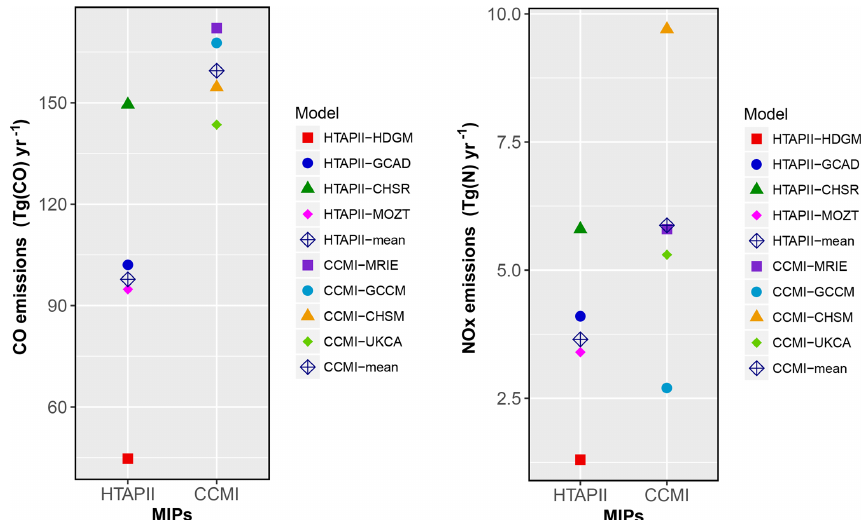
Figure 1. Shows the high variability in NO x and CO emissions (anthropogenic + natural) between the two MIPs over the domain considered in this study. CCMI models show larger variability for NO x emissions and HTAPII models shows larger variability for CO emissions.